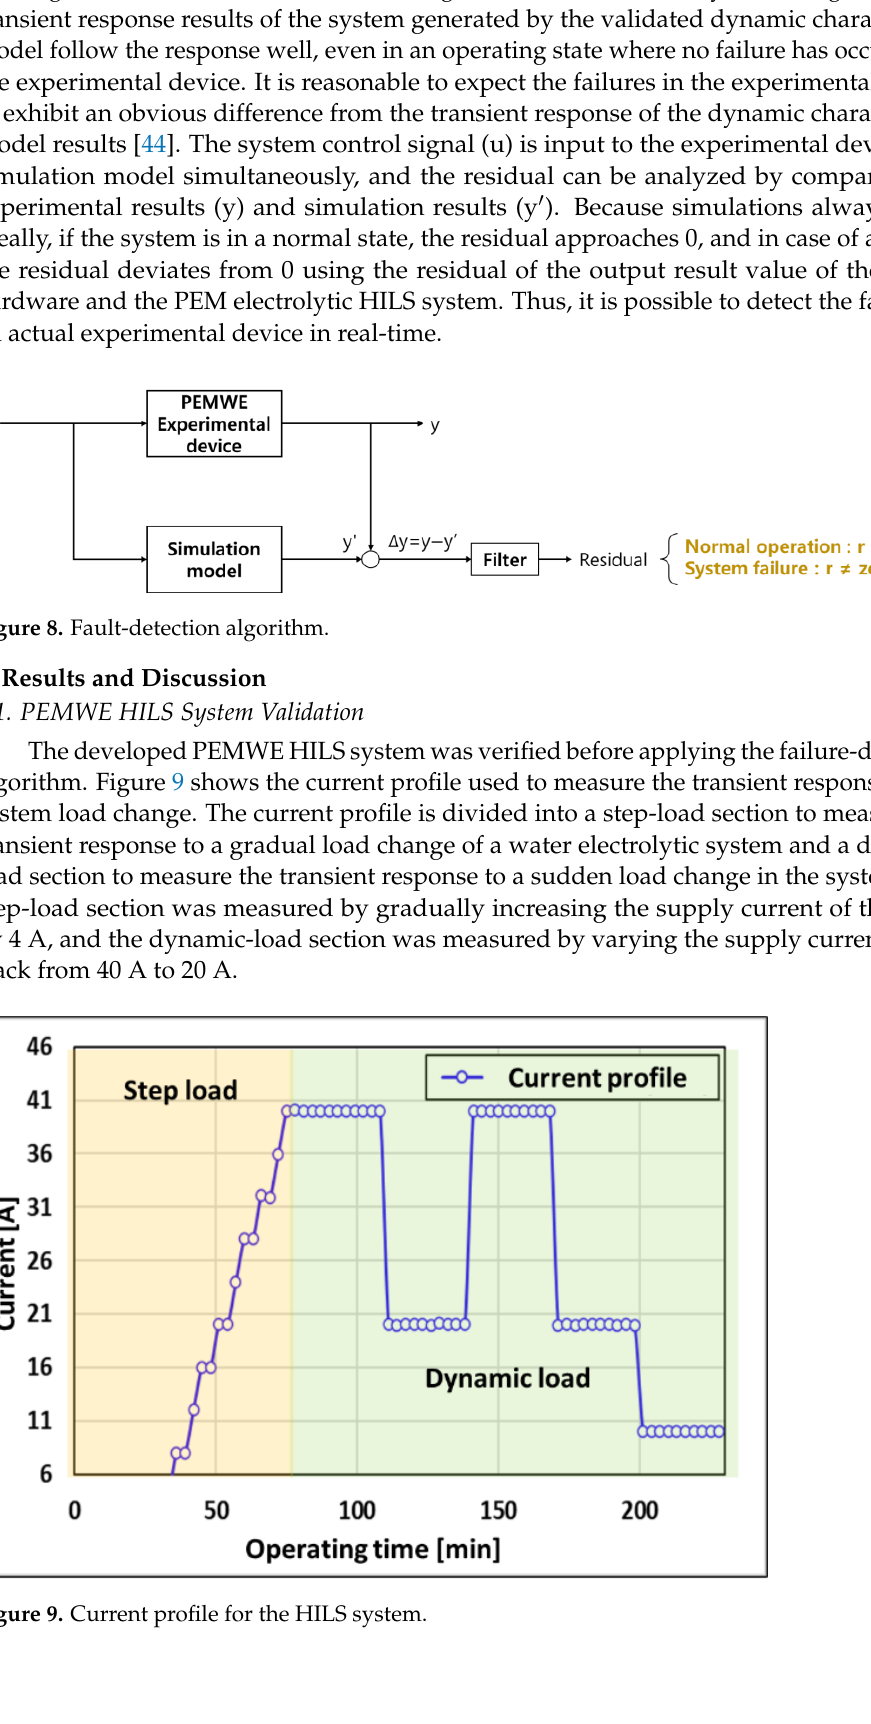
Figure 7. Signal flow chart of the PEMWE HILS system.